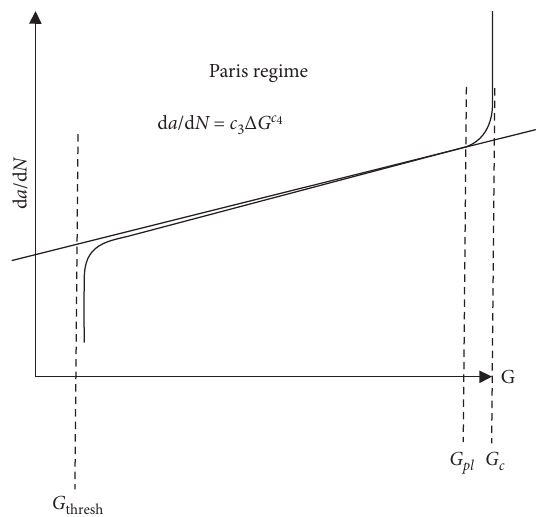
Figure 4: Fatigue crack growth rate-Paris regime (central